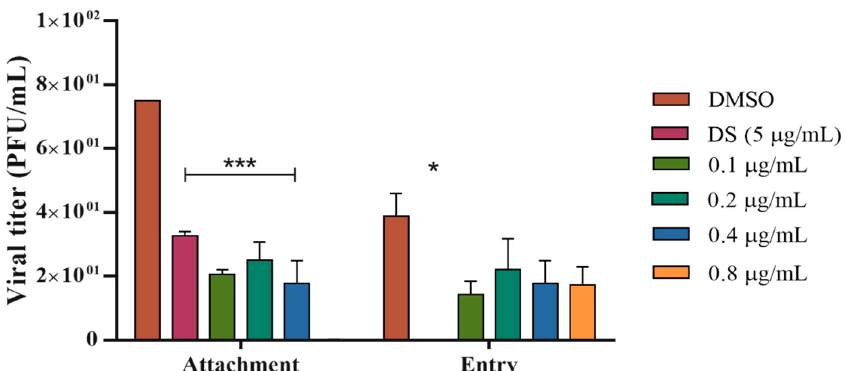
Figure 3. Effect of NQ 4 on HHV-1 viral attachment and entry on Vero cells. Vero cells were infected with HHV-1 and treated with different concentrations of NQ 4 at viral attachment or entry (see details in Materials and Methods). Bars represent the mean ± SEM relative to DMSO control from two independent experiments. p values were determined by unpaired Student’s T-test (***, p < 0.001; *, p < 0.05). DMSO: dimethyl sulfoxide; DS: dextran sulfate (5 µg/mL); NQ 4 (0.1–0.8 µg/mL).